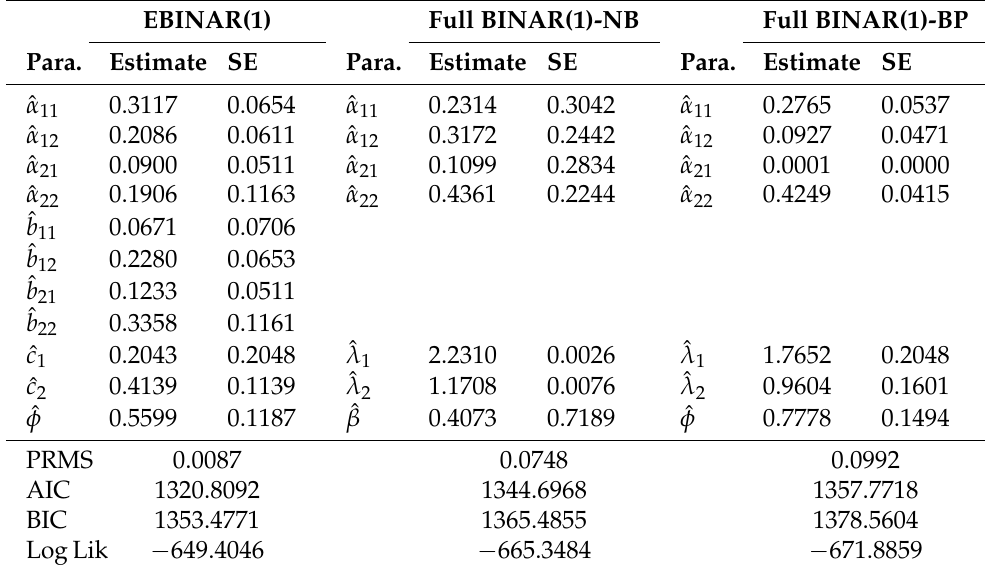
Table 9. Estimates for the monthly number of burglaries and robberies in beat 26.